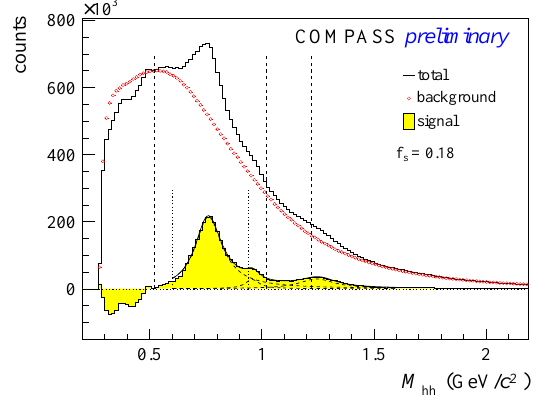
Figure 1: Total invariant mass distribution of h + h − pairs (continuous empty his- togram), estimated background from the h + h + and h − h − pairs (points) and the signal distribution (filled